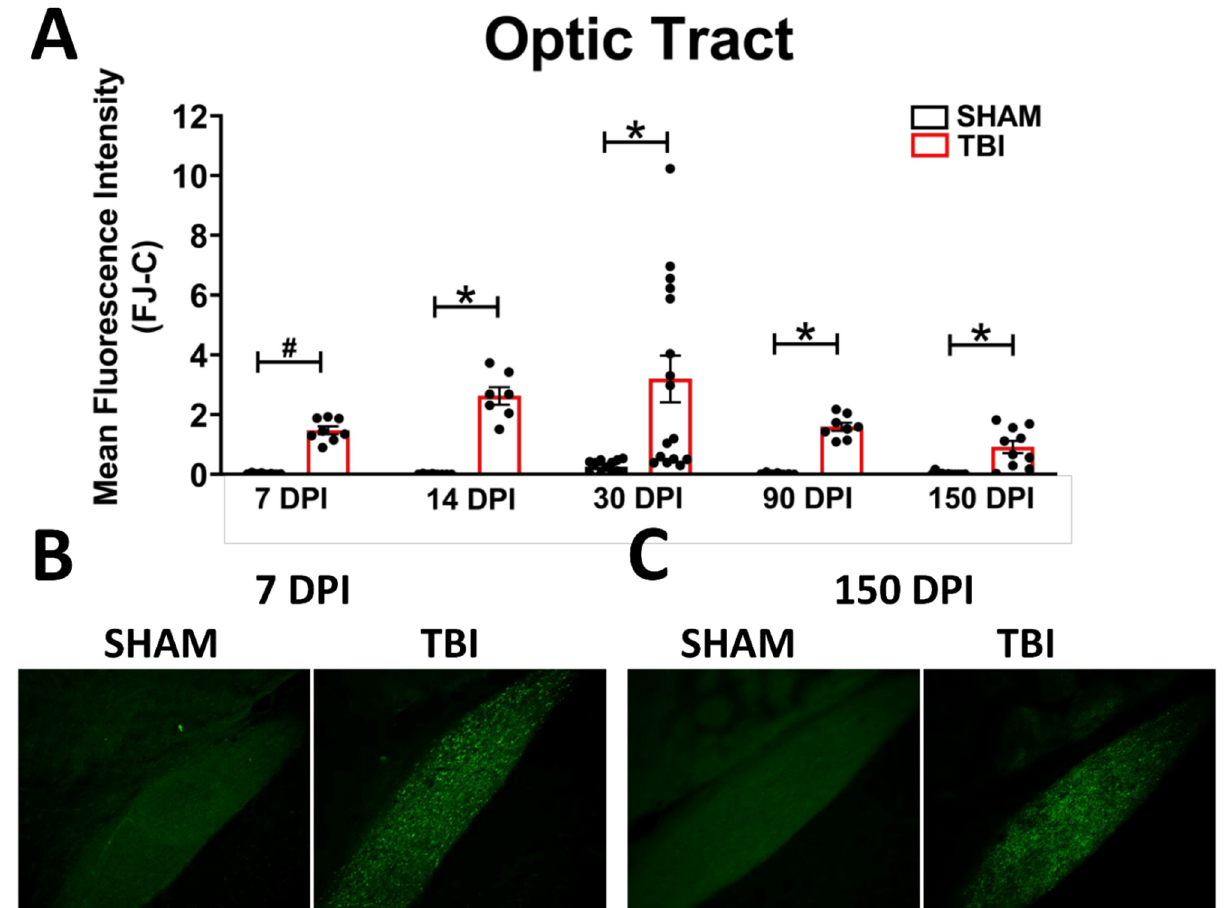
Figure 2. Degeneration in this model begins in the optic nerve and propagates through the optic tract throughout the time course. ( A ) There is significant degeneration (FJ-C staining) in injured mice at all time points compared to sham. Representative images of degeneration early ( B ) and chronically ( C ) after TBI were taken at 20× magnification with a scale bar representing 100 μ m. * p < 0.001, # p < 0.05 for sham vs. TBI within a time point.